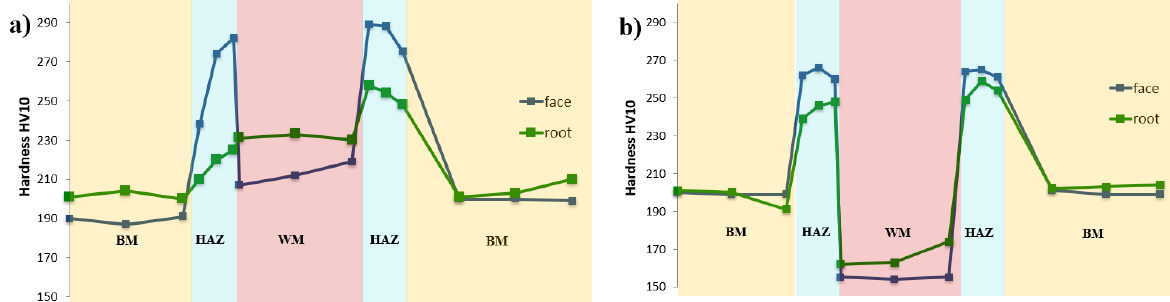
Figure 10. Nernst’s fingers in the weld of joint No. 2.